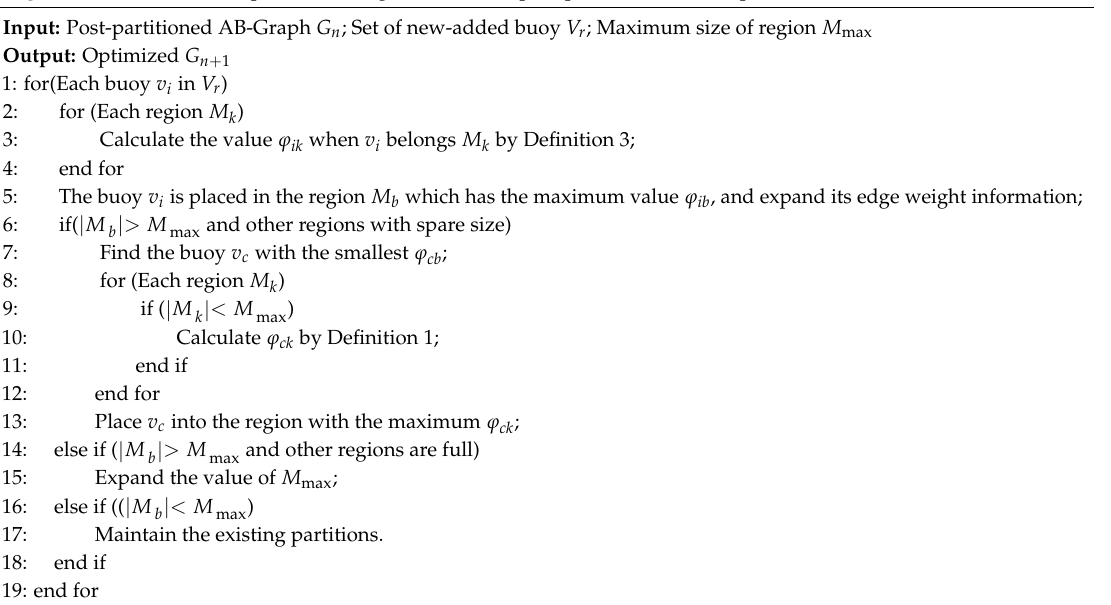
Algorithm 4 : Incremental optimization algorithm for the post-partitioned